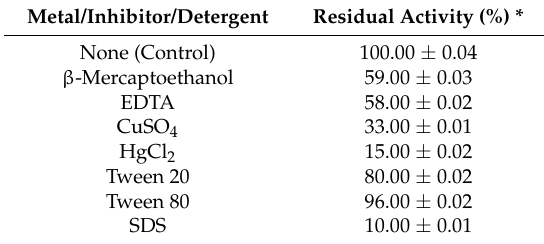
Table 2. Effects of metals and inhibitors (1 mM) on the purified C12O from Pc UFB2. Table 2 . Effects of metals and inhibitors (1 mM) on the purified C12O from Pc UFB2.